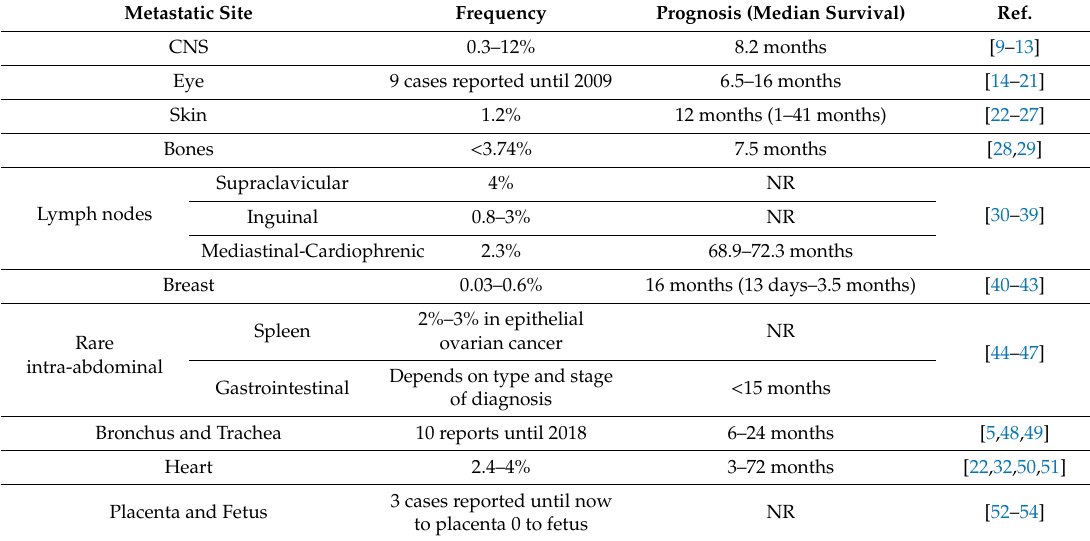
Figure 1. Rare distant metastatic sites of ovarian cancer and their route of metastasis. Table 1. Metastatic sites, frequency and prognosis and peritoneal carcinomatosis.